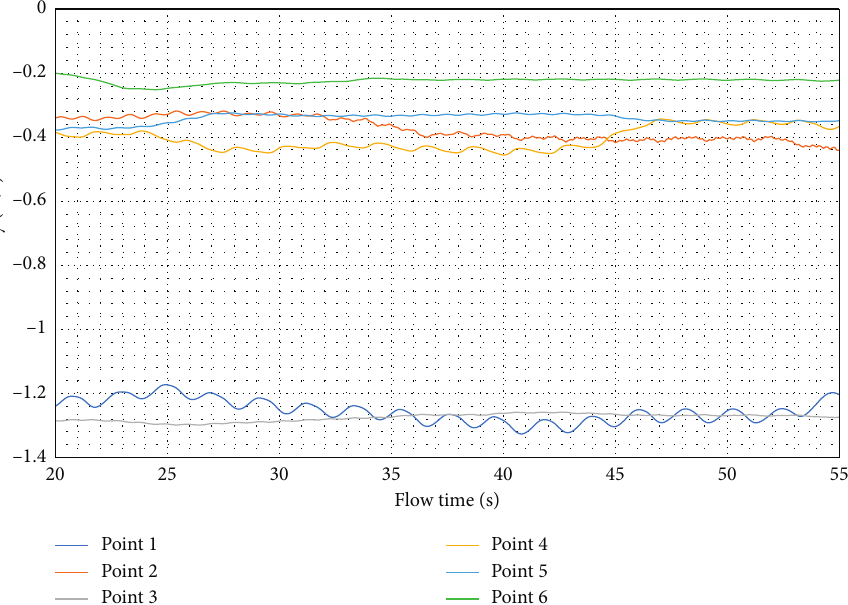
Figure 15: Velocity in the function of time along the z -direction V